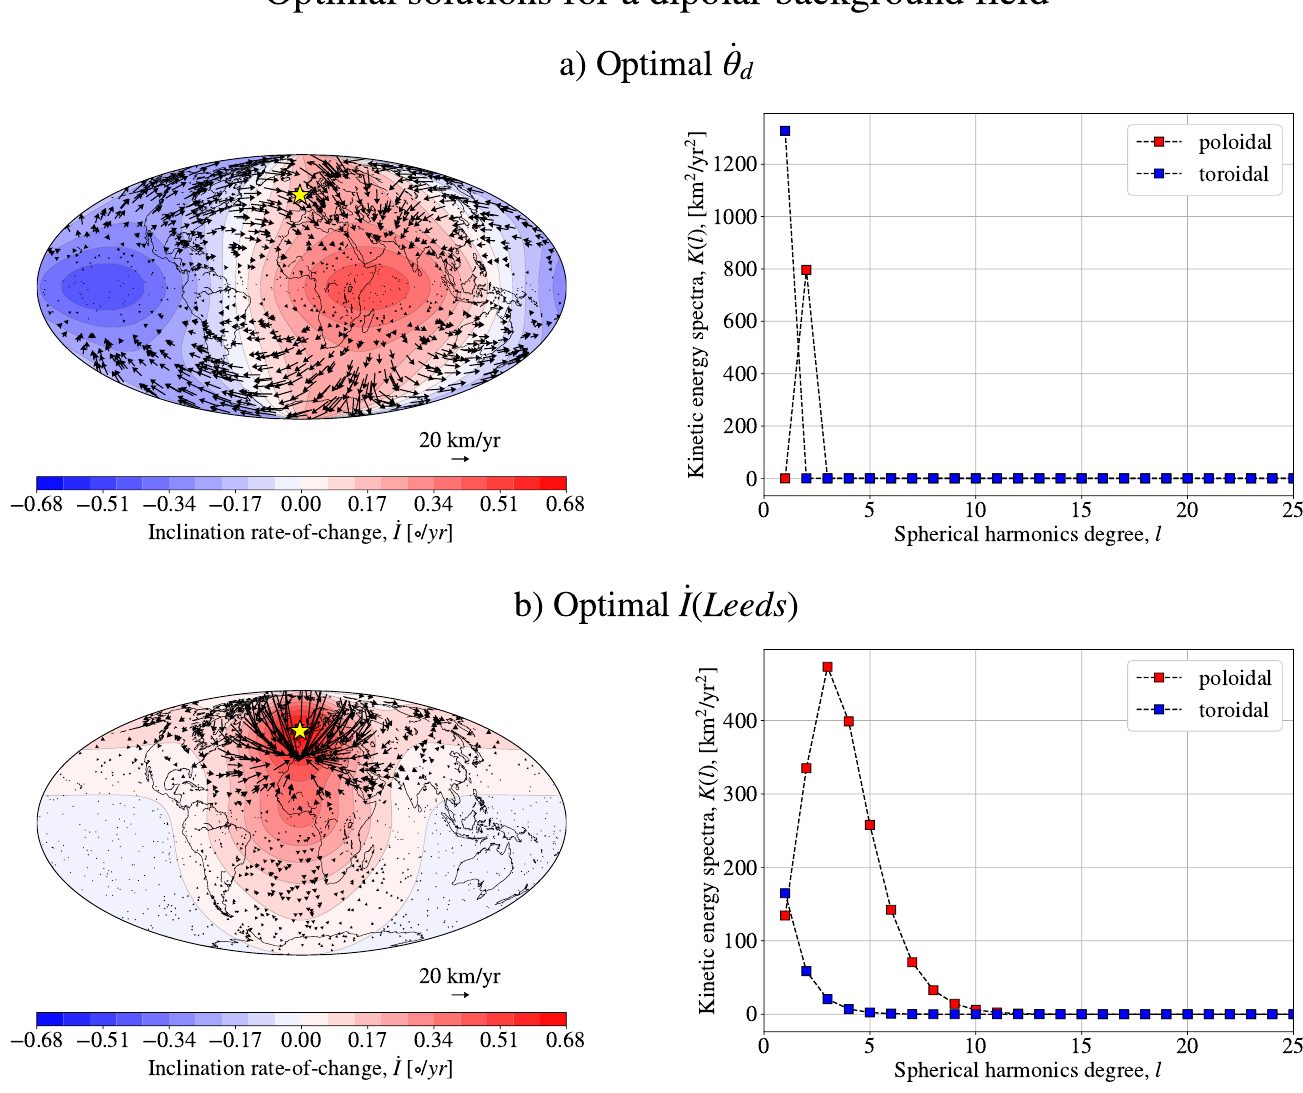
Figure 2. Flows that optimise the rate of change of θ d ( a ) and I at Leeds ( b ) with a background magnetic field given by a dipole. All solutions were calculated for T 0 = 13 km/y and a background dipole intensity given by g 0 = h 1 = 10 − 5 nT) horizontal component was added for the calculation of ˙ θ small ( g 1 1 1 optimal flow and resulting global maps of ˙ I . The plots on the right show energy spectra for the toroidal and poloidal flow contributions for the same choices of g 0 and T 0 . In all cases, L U = 1